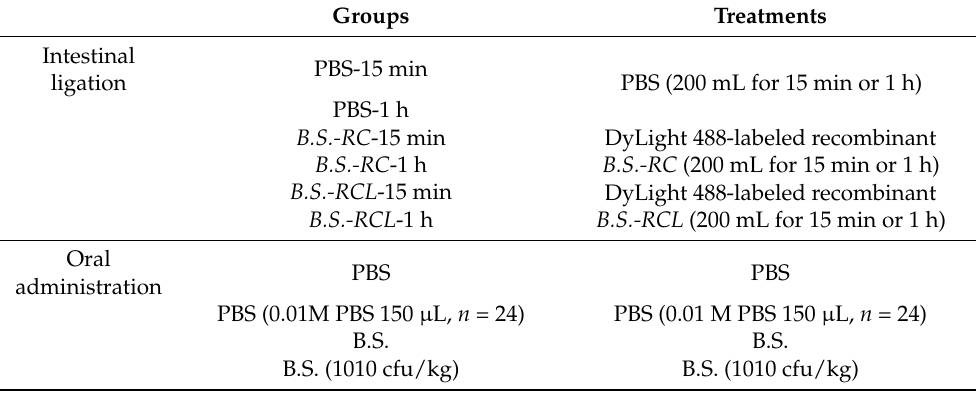
Figure 1. Immunisation and sample collection scheme. Table 1. Experimental groups and administration